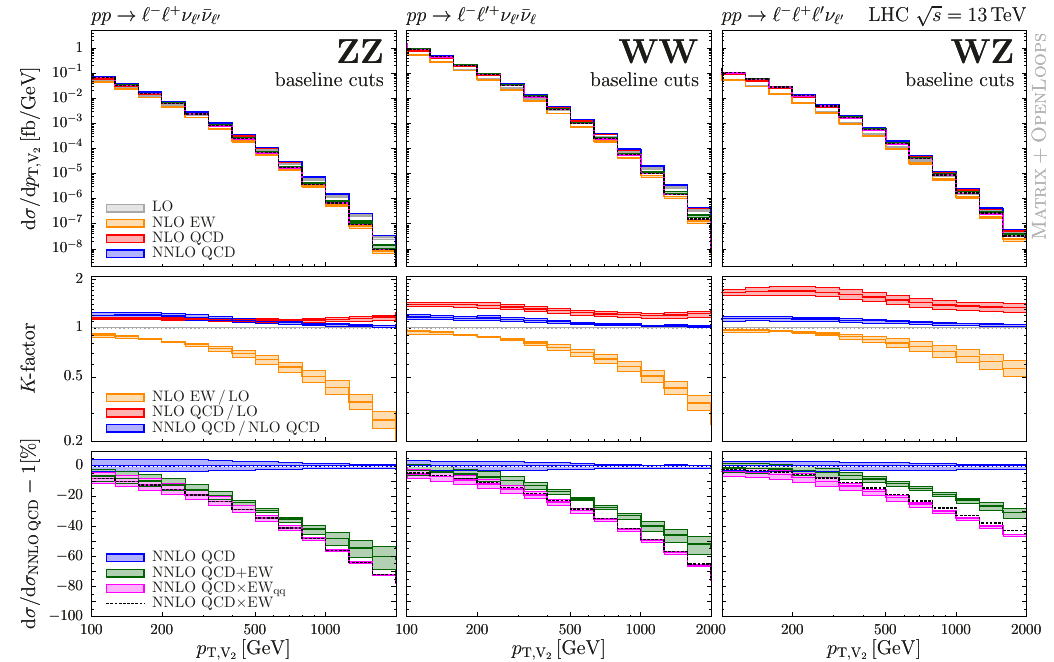
Figure 6 . Distribution in the transverse momentum of the softer vector boson for the ZZ (left), WW (centre) and WZ (right) production in pp collisions at 13 TeV. Baseline cuts without jet veto are applied throughout, and the o(cid:11)-shell vector bosons are reconstructed according to eq. (3.13). The top panel shows absolute predictions at LO (grey), NLO EW (yellow), NLO QCD (red) and NNLO QCD (blue). The centre panel shows NLO EW and NLO QCD predictions normalised to LO, and NNLO QCD predictions normalised to NLO QCD. The lower panel shows the di(cid:11)erent combinations of NNLO QCD with NLO EW corrections: the NNLO QCD+EW combination (2.6) (green), the NNLO QCD EW combination (2.7) (dashed black) and the modi(cid:12)ed NNLO QCD EW (cid:2) (cid:2) combination (2.13) (magenta), all normalised to NNLO QCD. Uncertainty bands correspond to seven-point factor-two scale variations as de(cid:12)ned in section 3.1, and in the ratios the variation is only applied to the numerator. Scale variation bands on top of NNLO QCD EW are omitted in (cid:2) order to improve legibility. They are basically identical with scale variations at NNLO